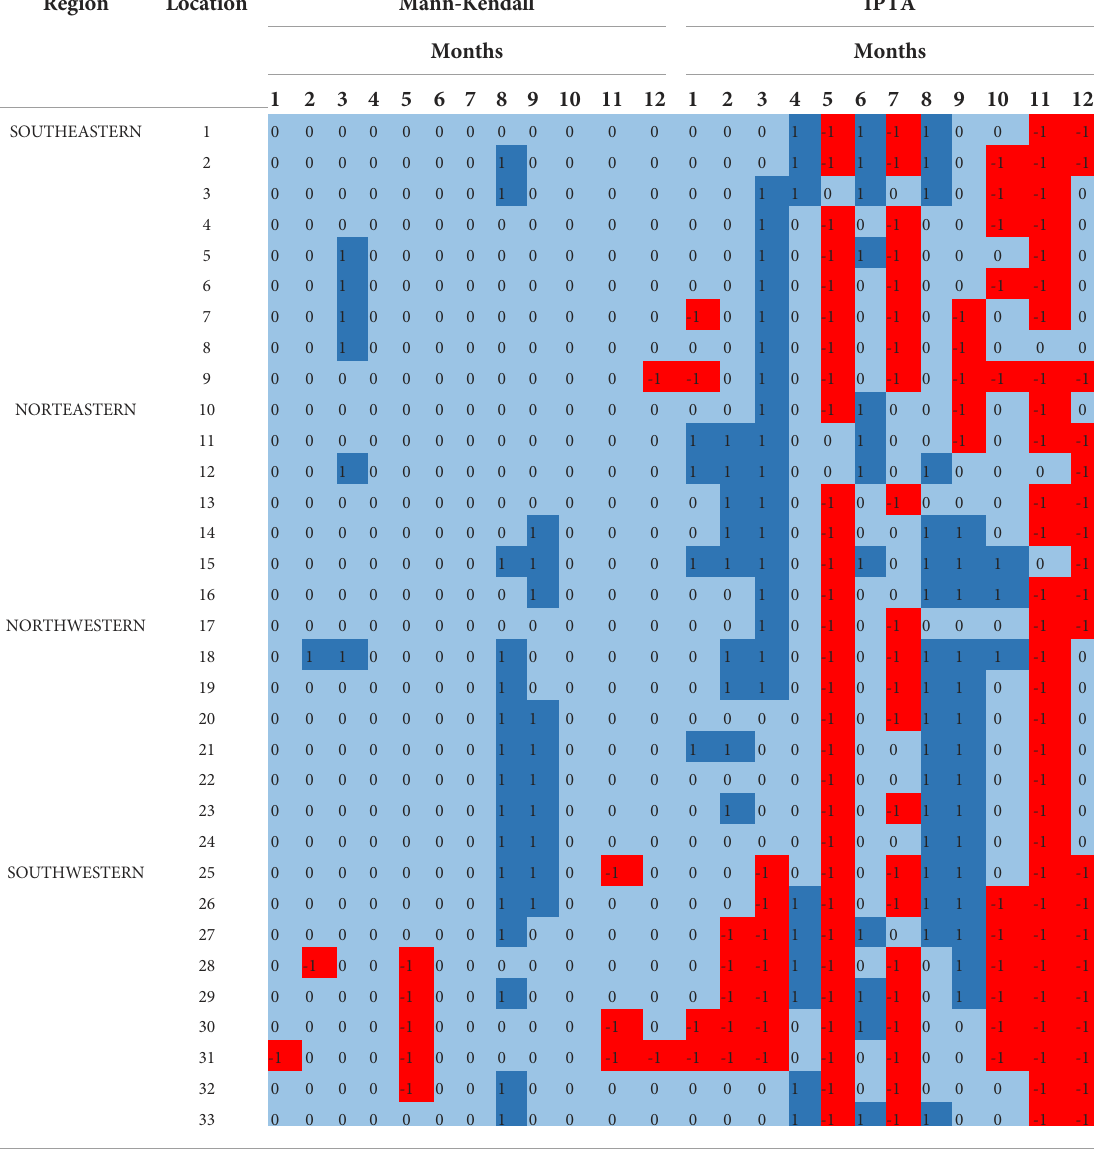
TABLE 1 Comparison of trend test results from different methods for mean SWH. Parameter